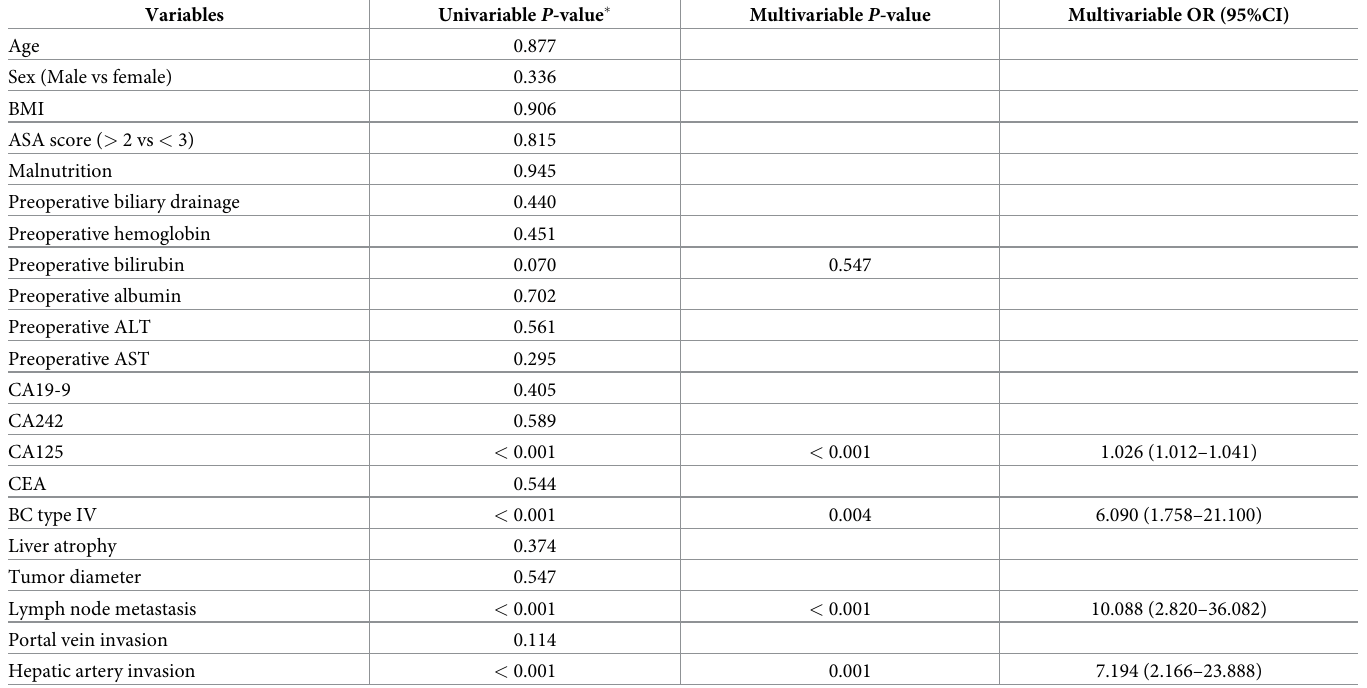
Table 4. Univariable and multivariable logistic regression analyses of training cohort predicting intraoperative unresectability.